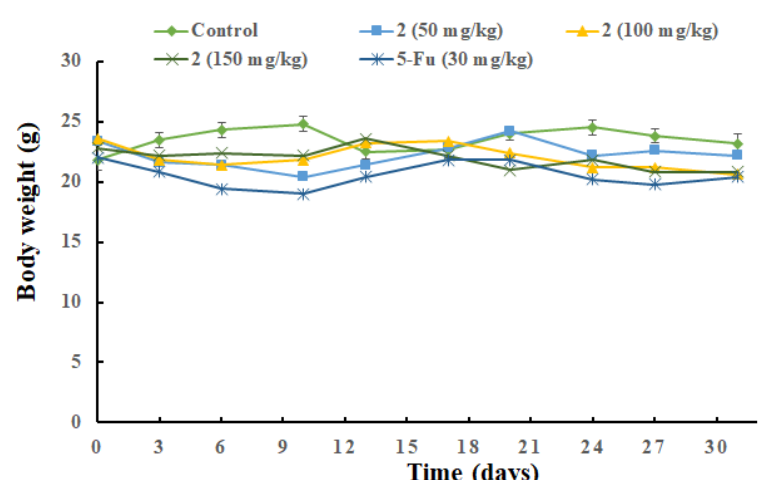
Figure 3. Mean body weight-time profile of 2 - administrated and control groups.